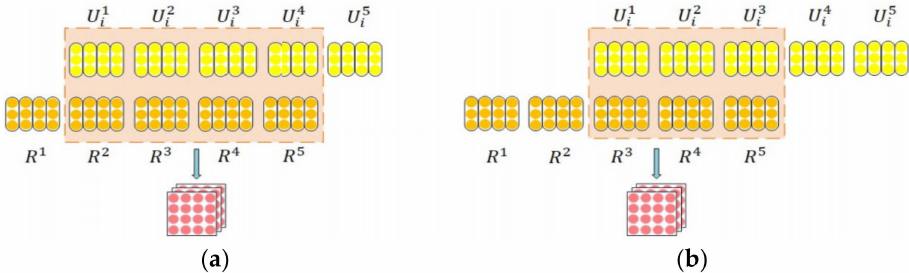
Figure 1. Shifted granularity matching module. ( a ) In the matching phase of the model, the granular- ity representation of response is mismatched with the granularity representation of utterance for the multi-layer granularity representation generated by the stacked self attention modules. ( b ) a matching module with a misalignment distance of 2. In Figure 1, the yellow blocks represent the granularity of utterance, orange blocks represent the granularity of response. While the orange boxes are used for one-to-one matching. Finally, the red-shifted granularity matching matrix is generated.